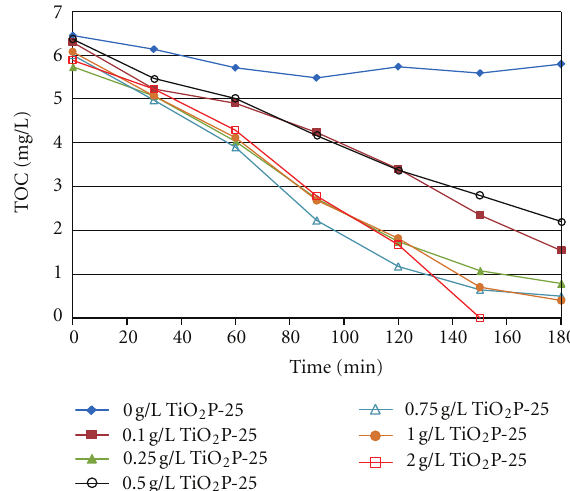
Figure 4: The TiO 2 P-25 dose influence on the degradation of mepiquat chloride (initial conditions: 10ppm mepiquat chloride, 0.5g/L TiO 2 P-25, UV-A